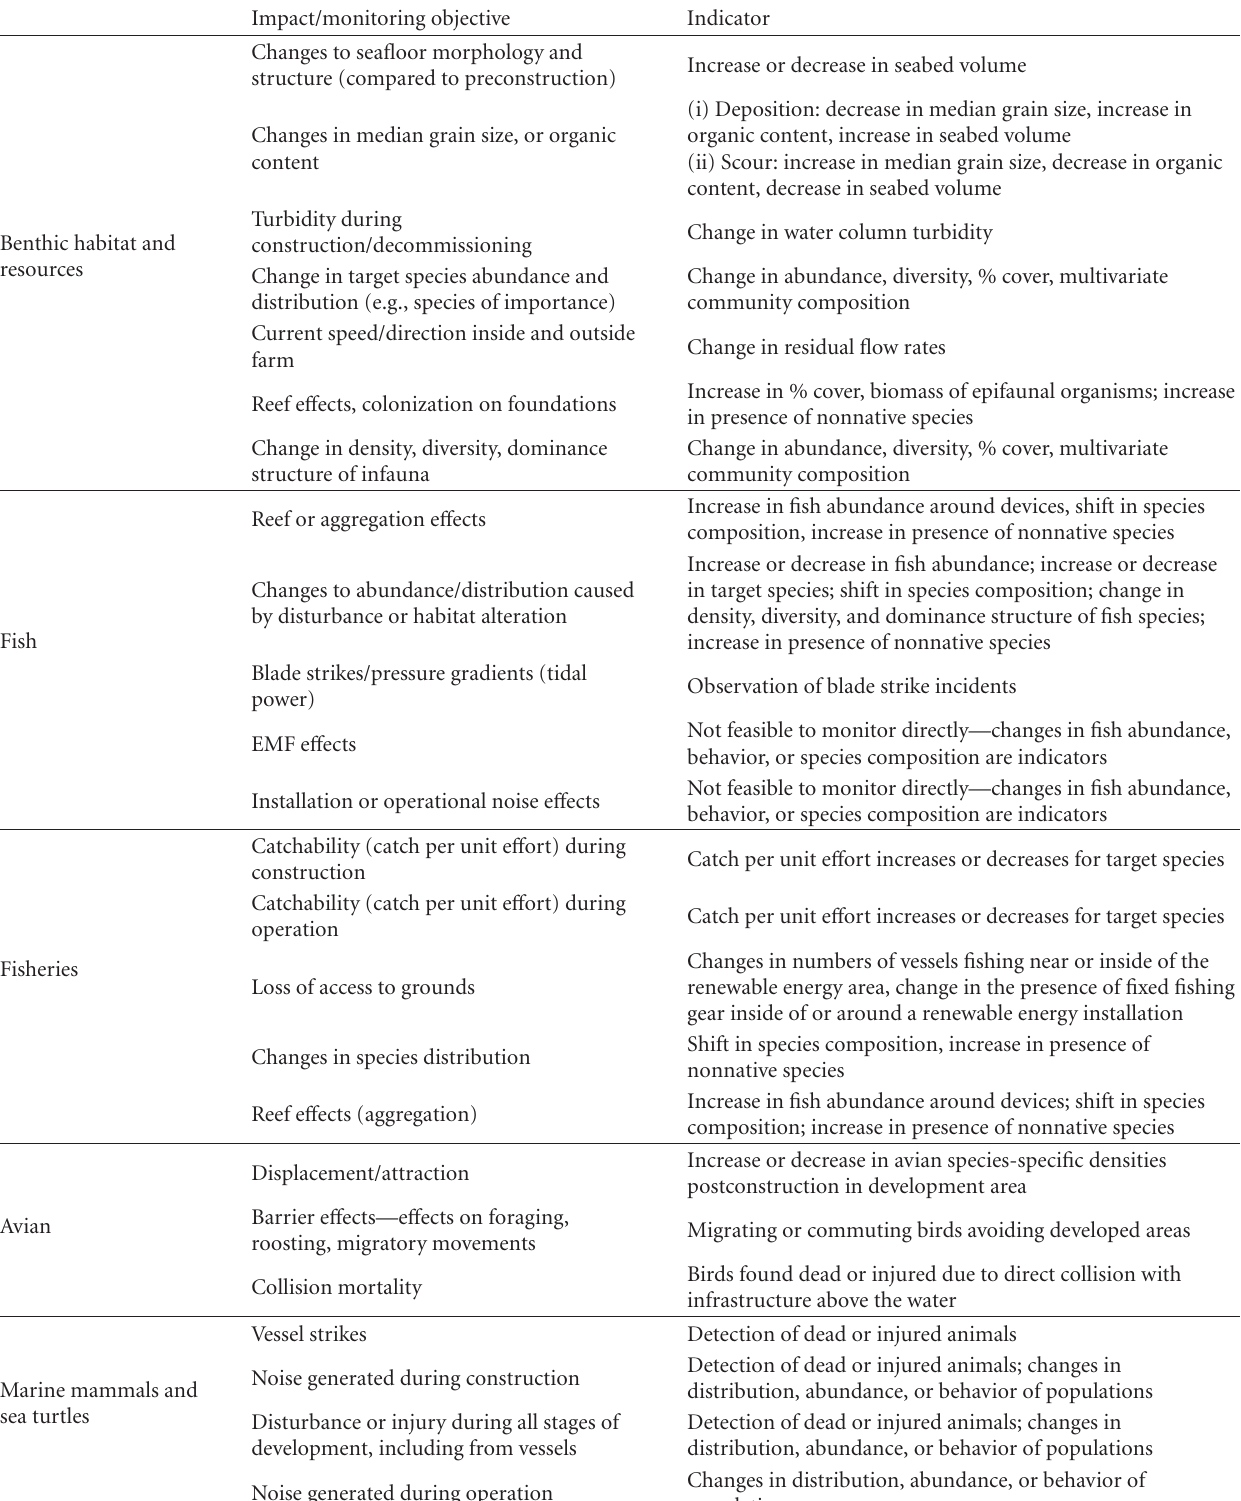
Table 1: Potential e ff ects of o ff shore renewable energy developments in the United States considered to be of greatest importance based on results of a literature review and expert judgment (see Supplementary Appendix A). E ff ects are organized by ecosystem component and are paired with a proposed indicator of that e ff